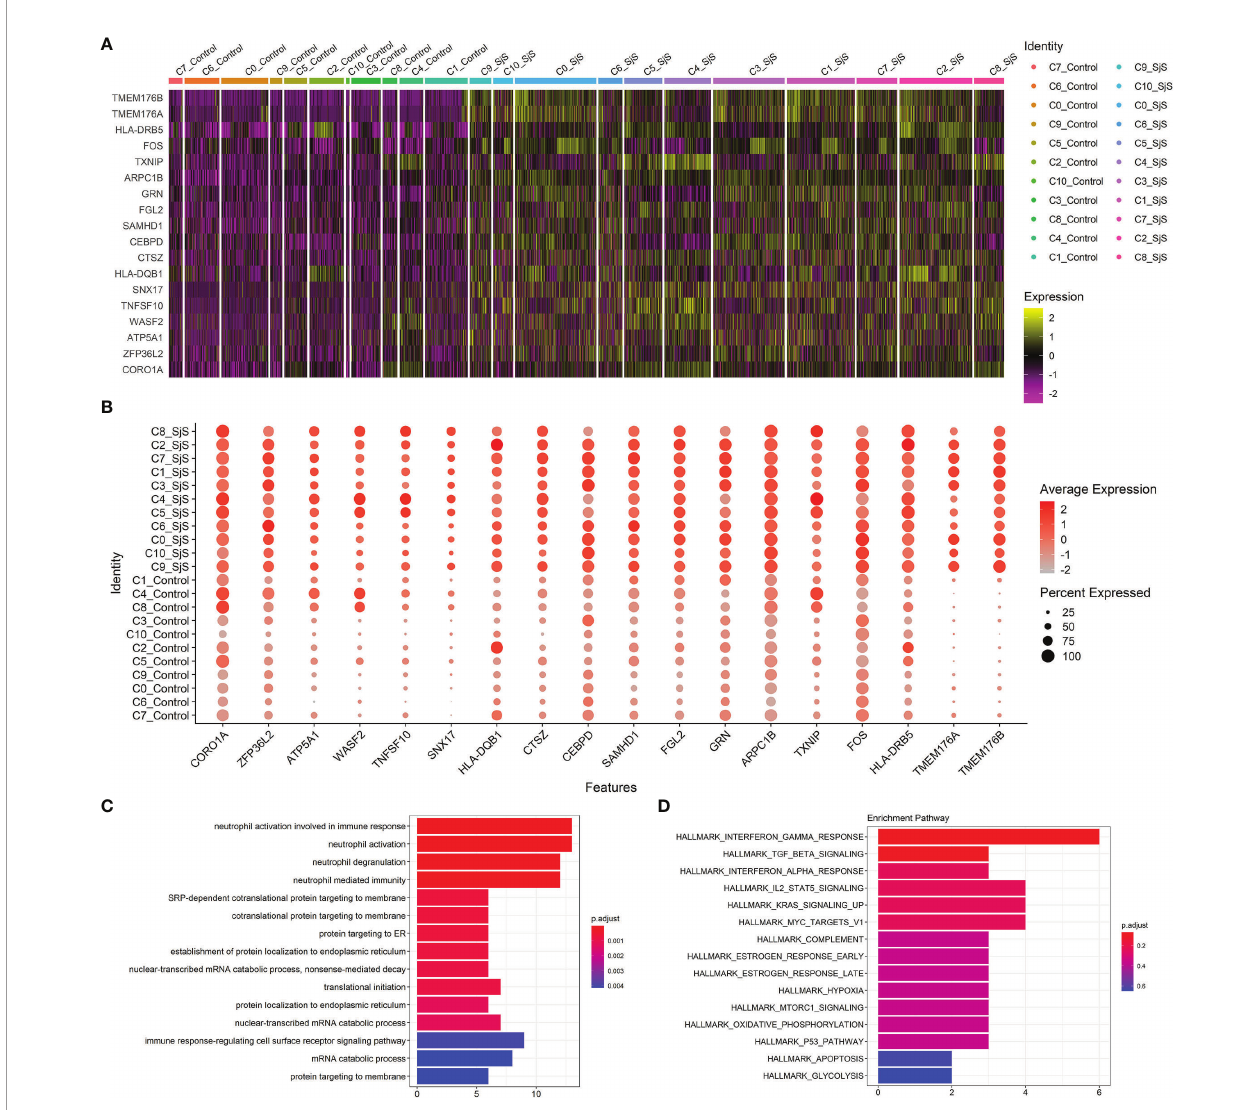
FIGURE 2 | Identi fi cation of transcriptomic changes in monocyte subsets of SjS patients via scRNA-seq transcriptome analyses. (A) , Heatmap shows the expression changes of key genes in those monocyte subsets between SjS patients and controls. (B) , Dot plot shows the expression percentages and the expression levels of key DEGs of monocyte subsets between SjS patients and controls. (C) , Main enriched GO pathways of those signi fi cant DEGs identi fi ed in scRNA-seq transcriptome analyses via clusterPro fi ler. (D) , Main enriched Hallmark pathways of those signi fi cant DEGs identi fi ed in scRNA-seq transcriptome analyses via clusterPro fi